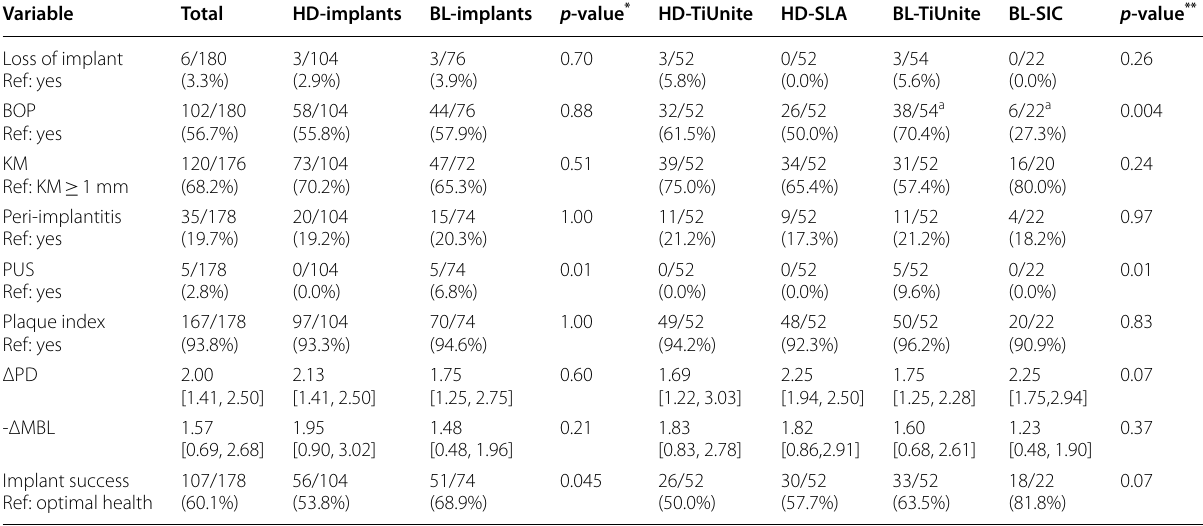
* P-value comparing HD- with BL-implants, ** P-value comparing implant types. a Groups with same letter show statistically significant post hoc tests